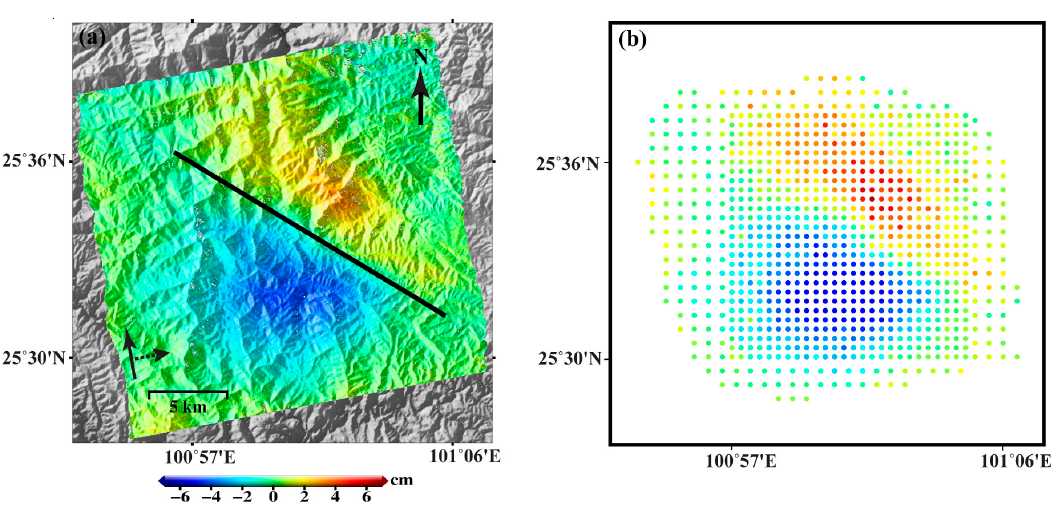
Figure 2. Coseismic interferogram ( a ) and resampled image ( b ) of the 2009 Yao’an earthquake. Table 1. Parameters of the SAR (Synthetic Aperture Radar) interferogram used in this study.